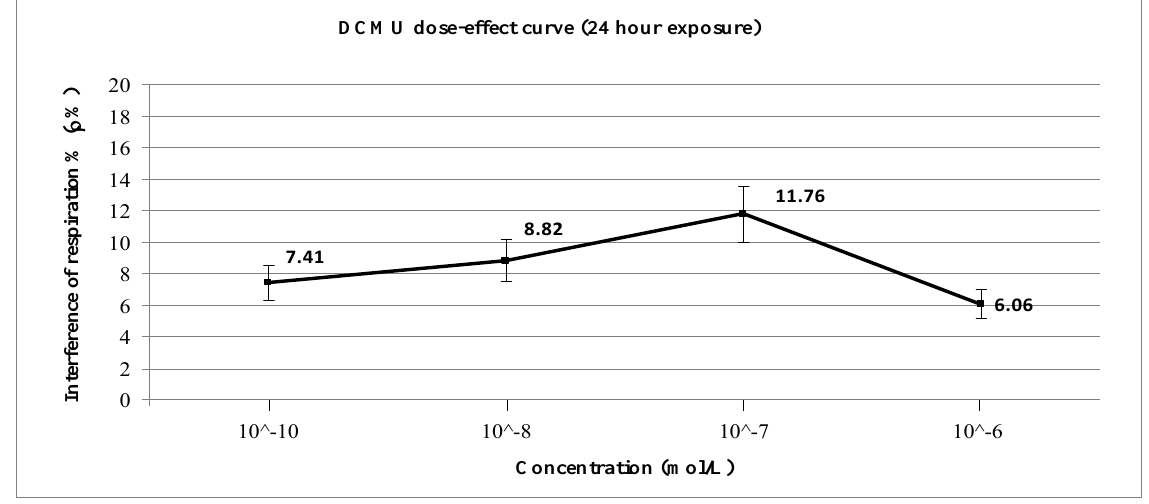
Figure 3. Dose-effect curve for long-term (24 h) exposure to diuron